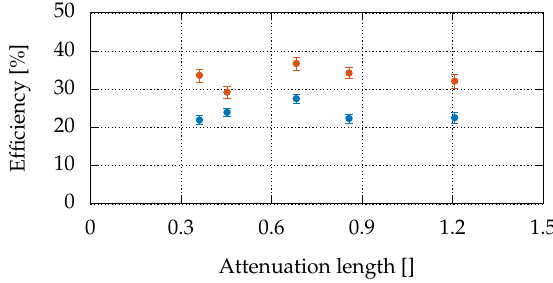
Figure 8. Efficiency as a function of attenuation length.